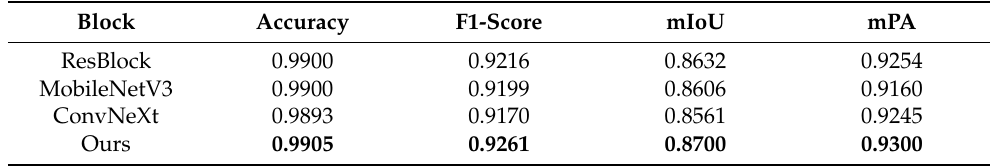
Table 4. Results of different blocks.